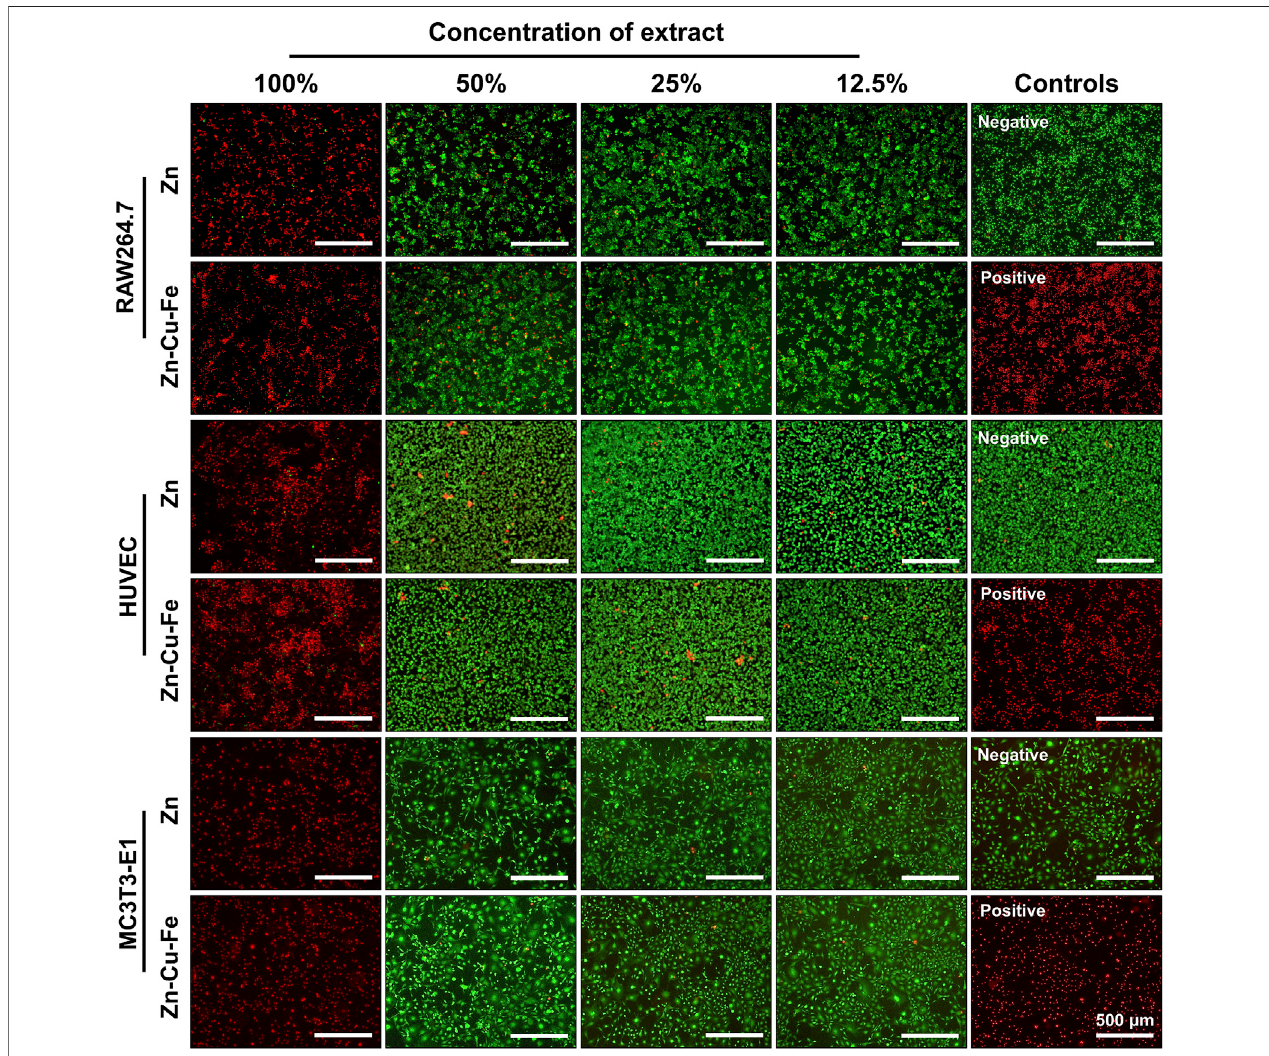
FIGURE5| Representative fl uorescenceimagesofRAW264.7cells,HUVECcells,andMC3T3-E1cellsexposedtosampleextractsfor24 h.Ti-basedalloyextract wasusedasanegativecontrol,withCuextractsasapositivecontrol.Green fl uorescencerepresentsviablecellswithmembraneintegritystainedbycalceinAM,andred fl uorescence indicates apoptotic cells stained by